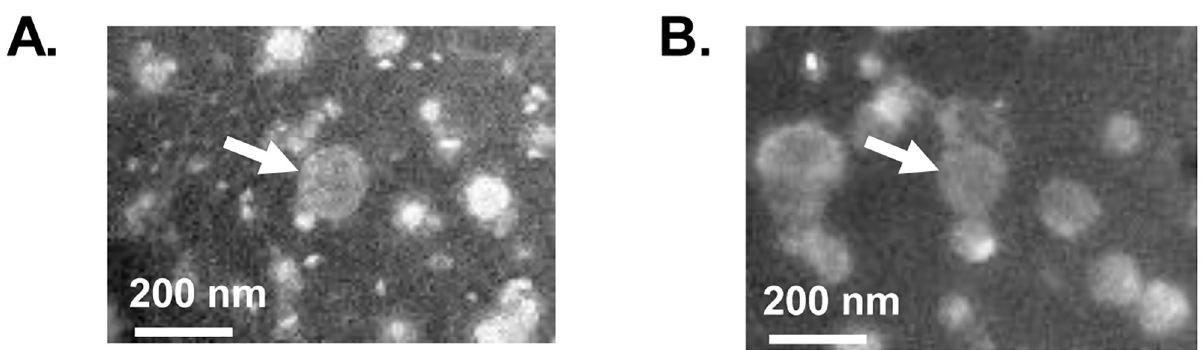
Fig 1. Negative-staining transmission electron micrographs of (A) nAbOMVs and (B) hAbOMVs. A . baumannii ATCC19606 were cultured under normoxic and hypoxic conditions for 24 h and 48 h, respectively. After removal of bacterial cells, nAbOMVs and hAbOMVs in the culture supernatant from normoxic and hypoxic conditions were collected and purified by step-gradient ultracentrifugation. AbOMVs (white arrows) from both conditions were detected in fraction F2.